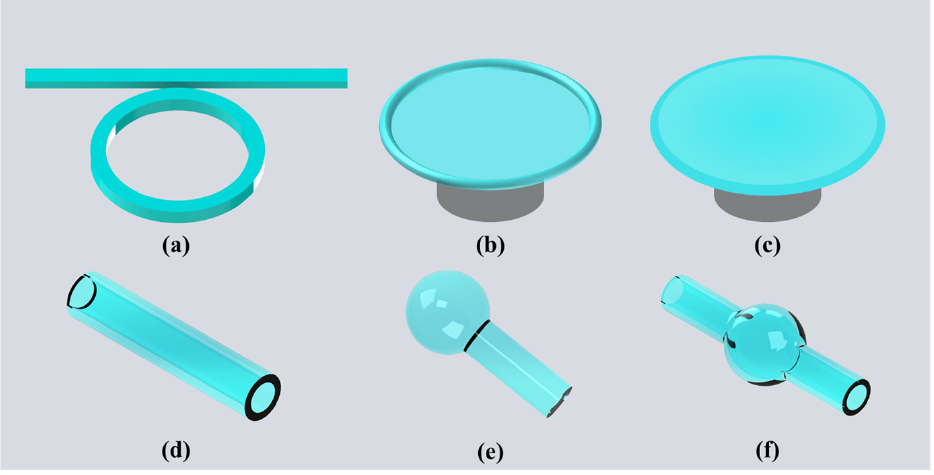
Figure 2. Types of WGM optical microcavities: ( a ) microring cavity; ( b ) microtoroid cavity; ( c ) microdisk cavity; ( d ) microcapillary cavity; ( e ) microsphere cavity; ( f ) microbubble cavity.